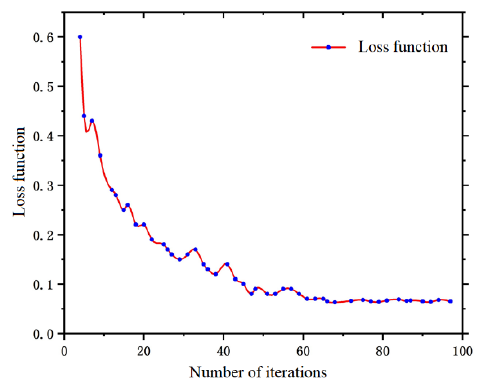
Figure 11. The loss function varies with the epoch number.